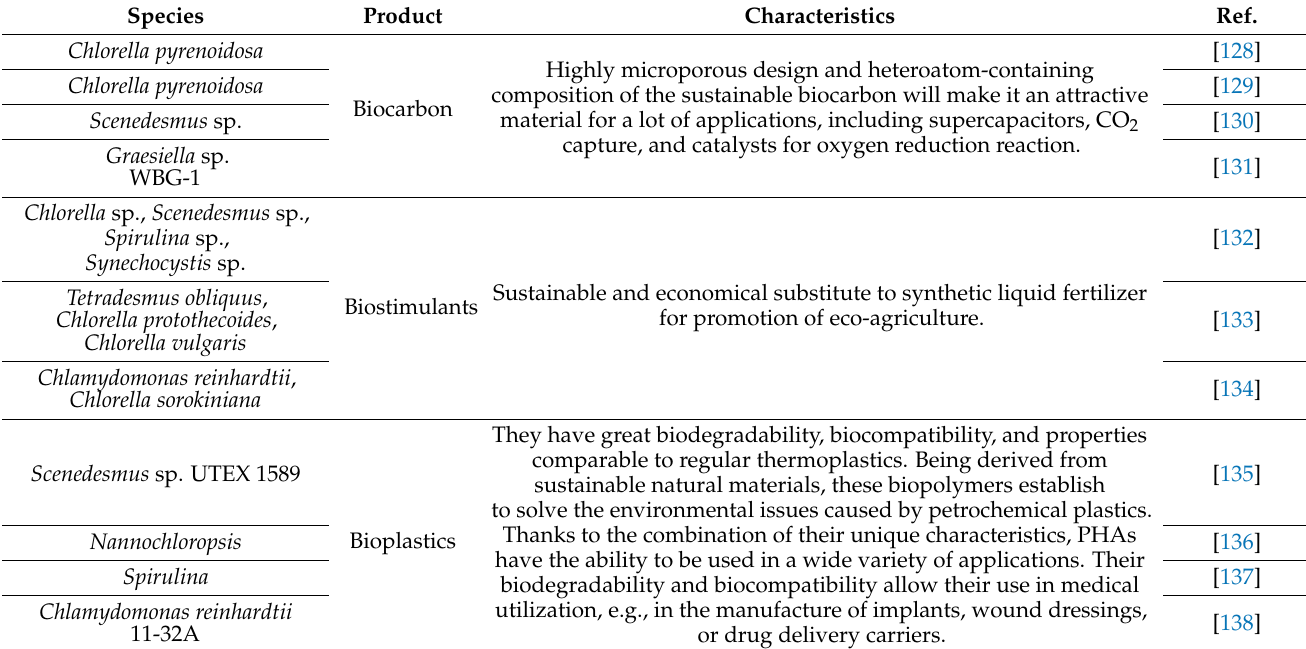
Table 5. Comparison of long-term products made with microalgal biomass that can help achieve negative CO 2